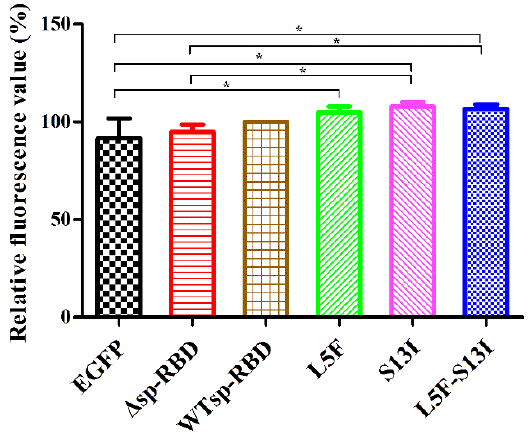
Figure 3. Analysis of RBD protein release regulated by signal peptide. WT means wild ‐ type signal peptide of S protein; the mutants L5F and S13I were present in Iota (B.1.526) and Epsilon (B.1.429) variants; L5F ‐ S13I was a newly constructed double mutant. Statistical significance was defined as p < 0.05, and * p < 0.05.